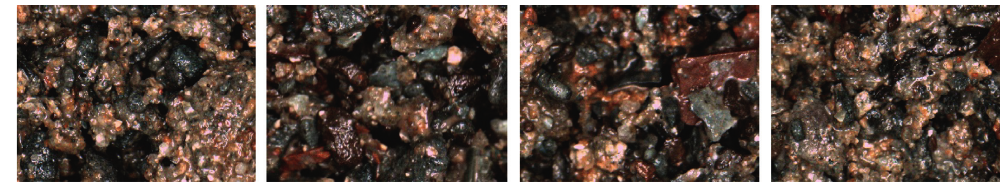
Figure 12: Partial results of test set data classified as light gray fine sandstone.